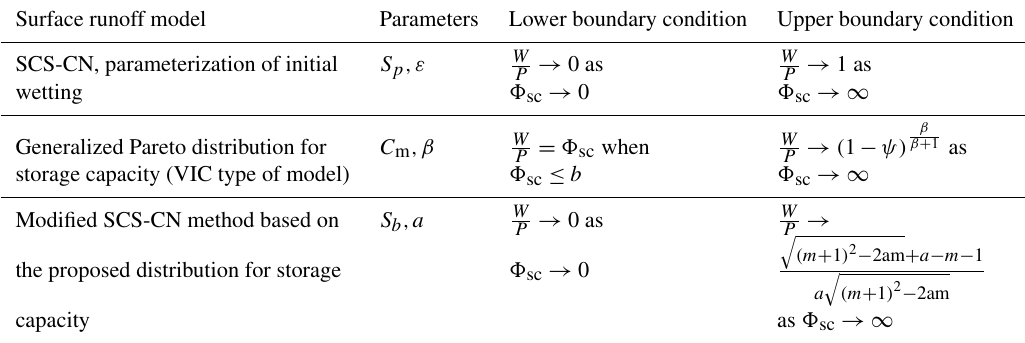
(cid:17) (cid:16) W to the soil storage index ((cid:56) sc ) : (1) the SCS-CN method, P → 0 as W → 1 as P P β = (cid:56) sc when W → ( 1 − ψ) β + 1 as P P → 0 as W → P P